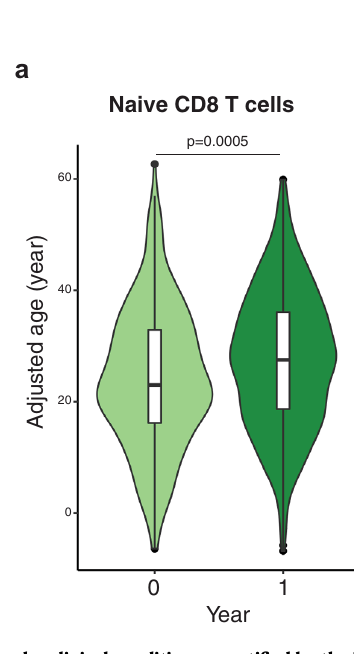
Fig. 7 | Aging of CD8 + T cells under clinical conditions quanti fi ed by the ML algorithm. a Predictedage increase in naïve CD8 + T cells during a one-yearcourse after diagnosis of HIV-1 infection (blood sample collection from HIV-1 infected patients and used for scRNAseq analysis 39 ). Predicted CD8 + T cell age at diagnosis and one year later (chronological increase in age was subtracted) based on Kazer etal. 39 . b PredictedageincreaseinCARTcellsduringthecourseoftreatment(CAR T cells collection at early and very late time points during the course of